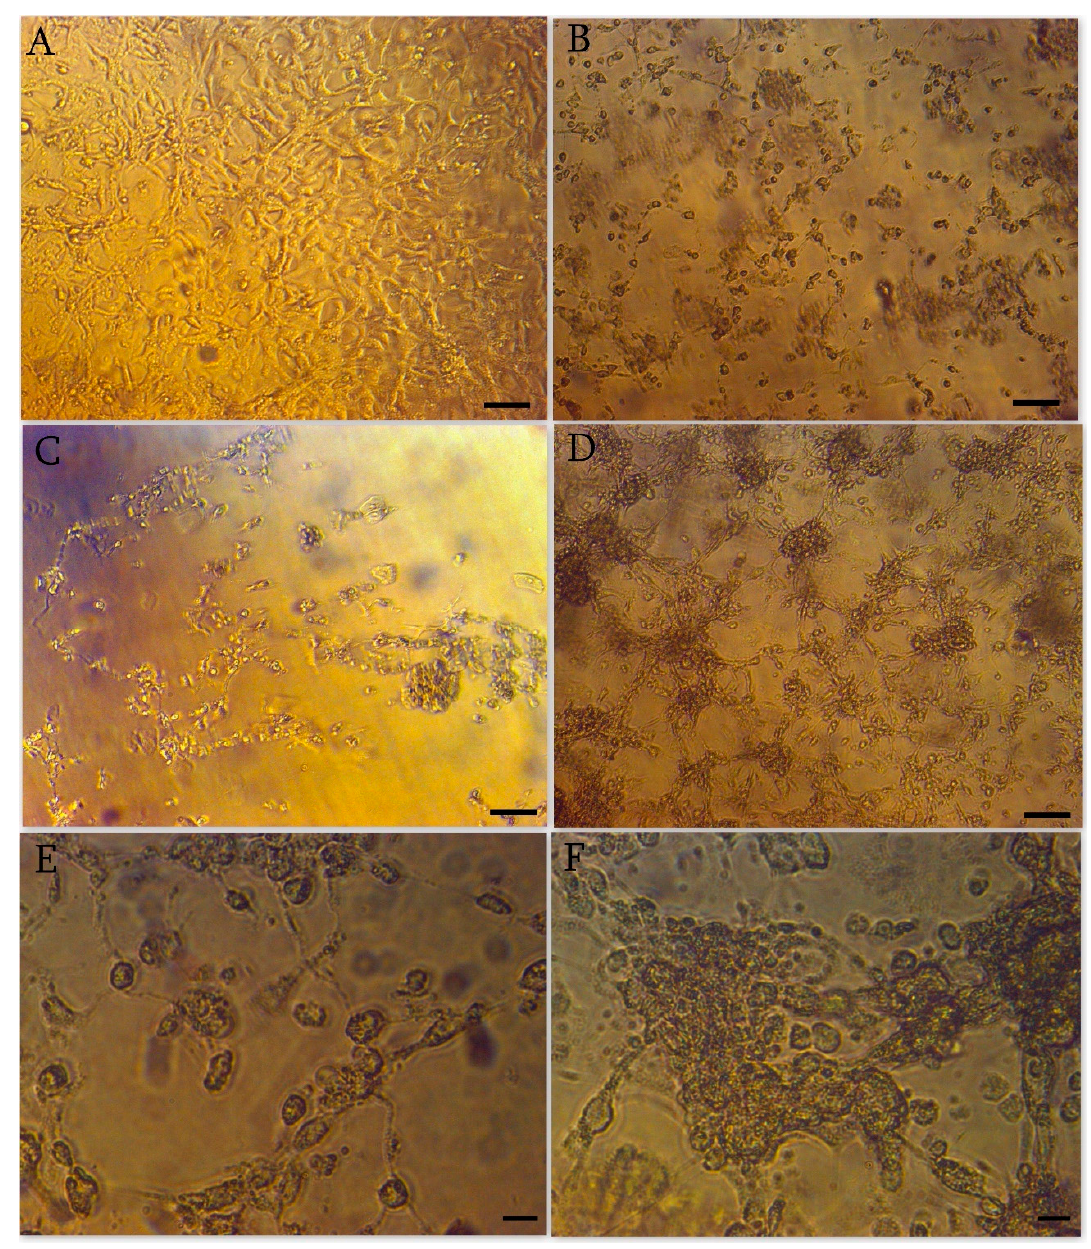
Figure 1. Cytopthic effect of SARS-CoV-2 on unstained Vero E6 cells. ( A ) Mock-infected control cells; scale bar 100 μ m. ( B ) Cell size reduction, cell rounding 96 hpi; scale bar 100 μ m ( C ) Cells deattachment, and syncytium formation; 120 hpi scale bar 100 μ m. ( D ) Cells rounding 120 hpi; scale bar 10 μ m. ( E ) Cells rounding, deattachment, and start of syncytium formation 120 hpi; scale bar 10 μ m. ( F ) Syncytium formation, 120 hpi; scale bar 10 μ m.